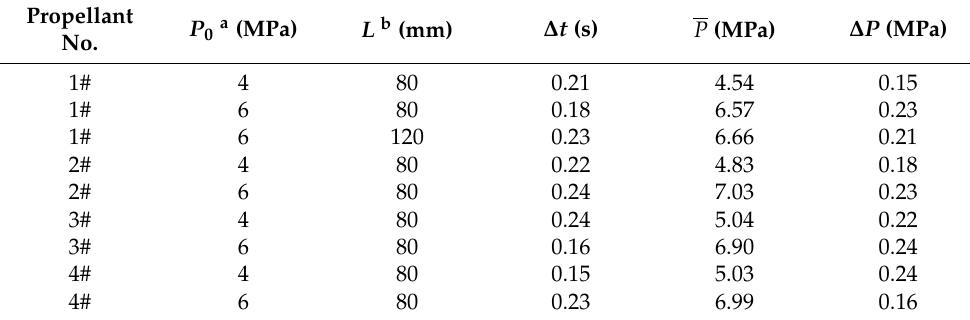
Table 2. Experimental conditions and results.